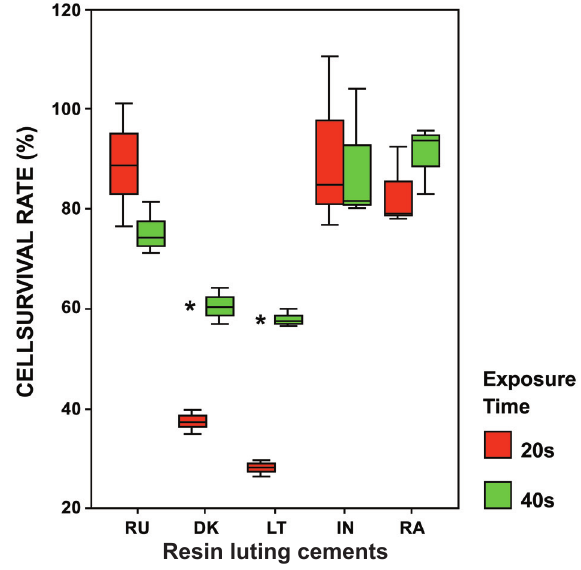
Resin luting cements Figure 3- Distribution of cell survival rates (%) according to the light exposure times (100% and 50%) for each resin luting cements. Cell survival rates are expressed as a percentage of controls (cultures without samples). Bars show the mean and standard deviations of three independent experiments. RU= Rely X Unicem; DK= Duolink; LT= Lute – It; IN= Illusion; RA= Rely X ARC Table 1- Cell survival rate (CSR) according to the light exposure times for each resin luting cement